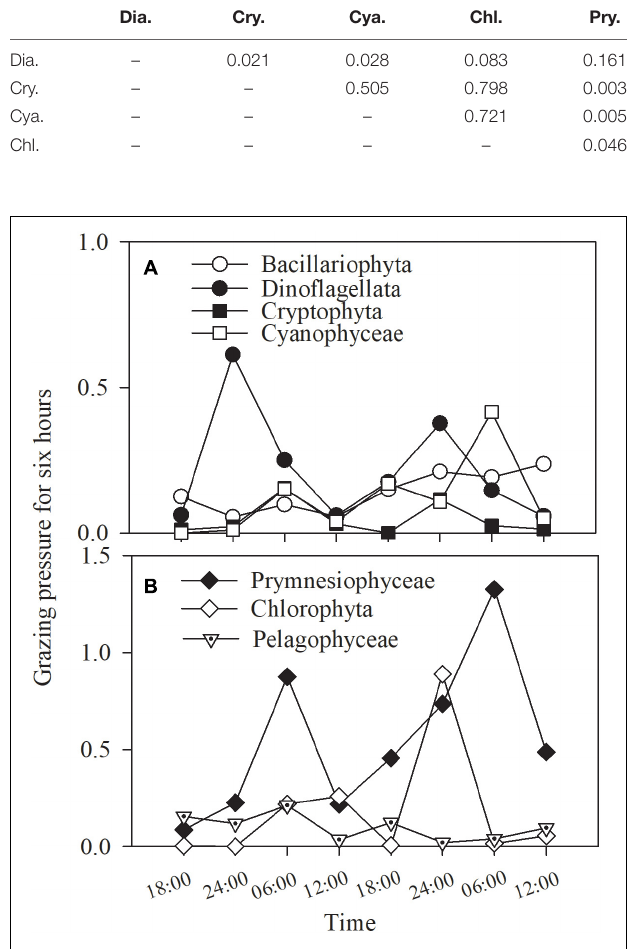
FIGURE 10 | Grazing pressure of the copepod assemblage on (A) Bacillariophyta, Dinoflagellata, Cryptophyta, Cyanophyceae and (B) Prymnesiophyceae, Chlorophyta, Pelagophyceae for 6 h in Daya Bay during September 30 to October 2, 2014.